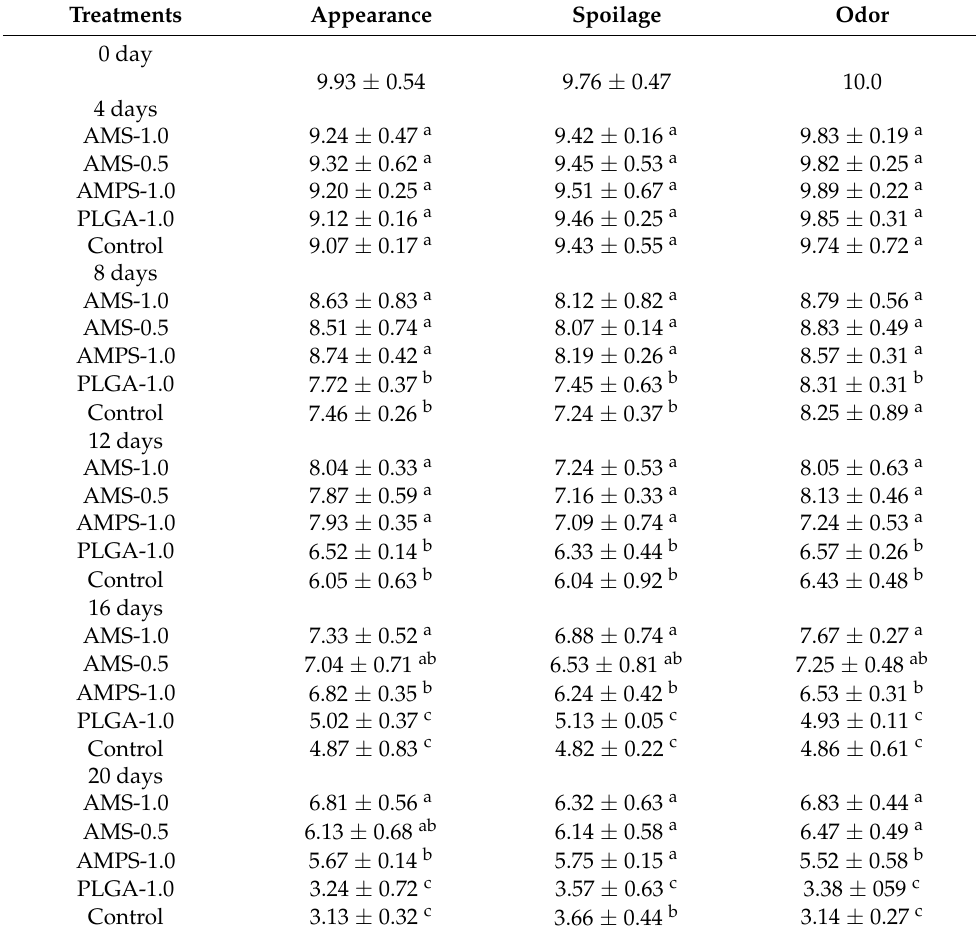
Table 1. Effect of different treatments on the color of Tricholoma matsutake mushrooms stored at 4 ± 1 ◦ C for 20